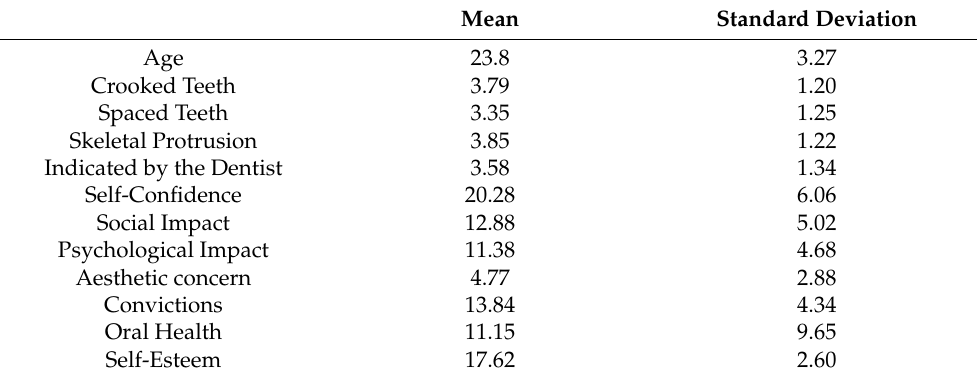
Table 2. Descriptive analysis for numerical data (PIDAQ, OHIP-14, Rosenberg Self Esteem Scale).